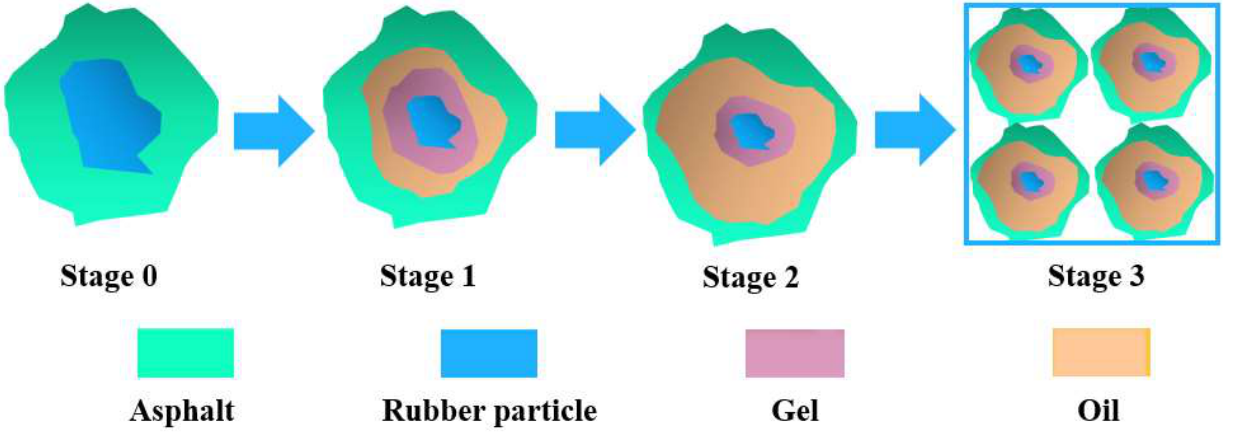
Figure 9. The asphalt–rubber interaction stages.